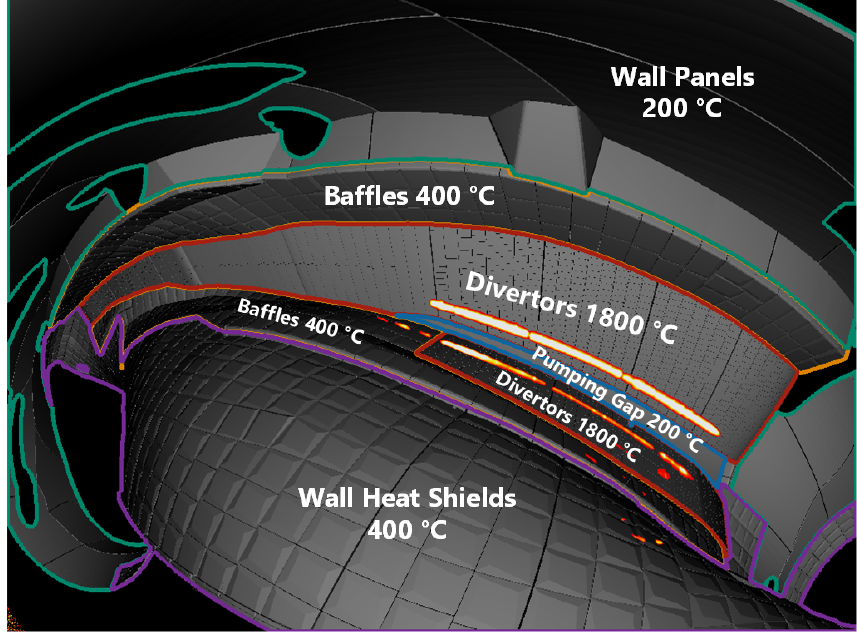
Figure 5. PFCs operational limits during Operational Phase (OP)